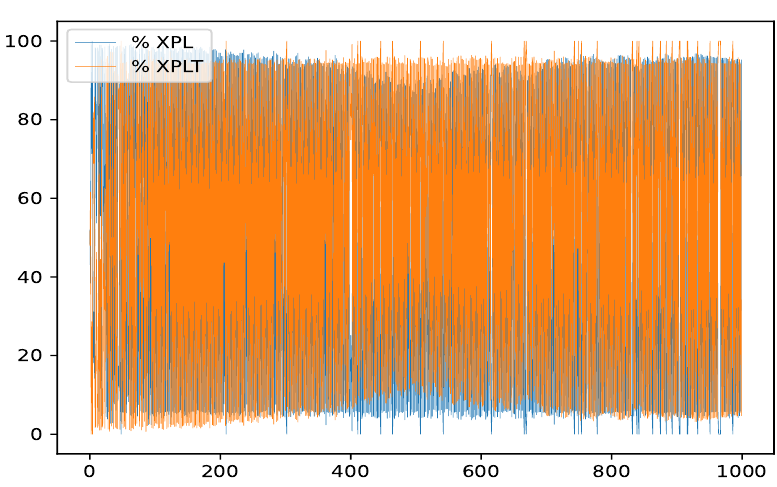
Figure 17. SCA-QL5-65 Dimensional Hussain.